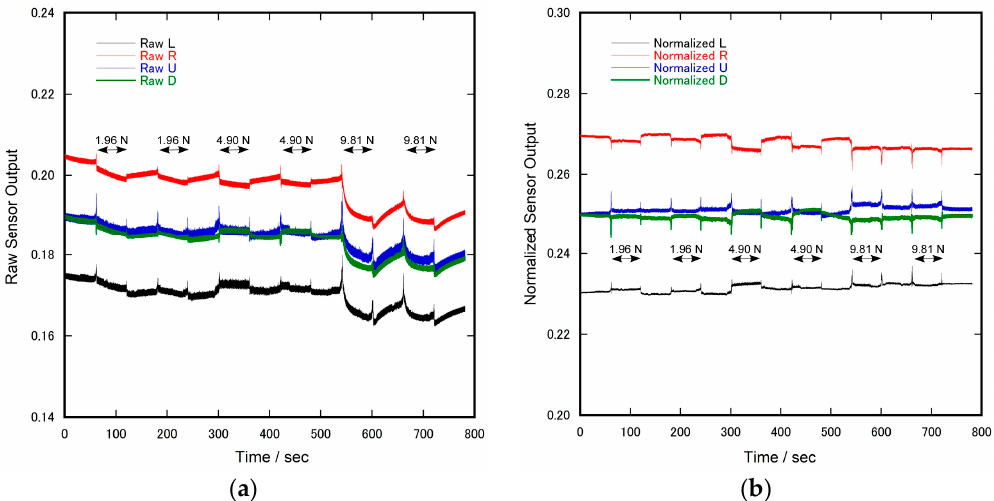
Figure 8. Time courses of the electrode output during the intermittent application of pressure (normal force): ( a ) Raw sensor output. The vertical scale of raw data is equivalent to the signal level of ADC (full range is 0.0–3.3 V); and ( b ) Normalized sensor output (no unit).